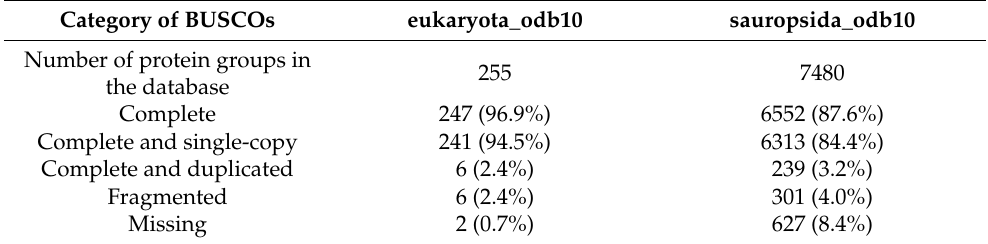
Table 2. Result of the BUSCO screening on the genome assembly of Darevskia valentini